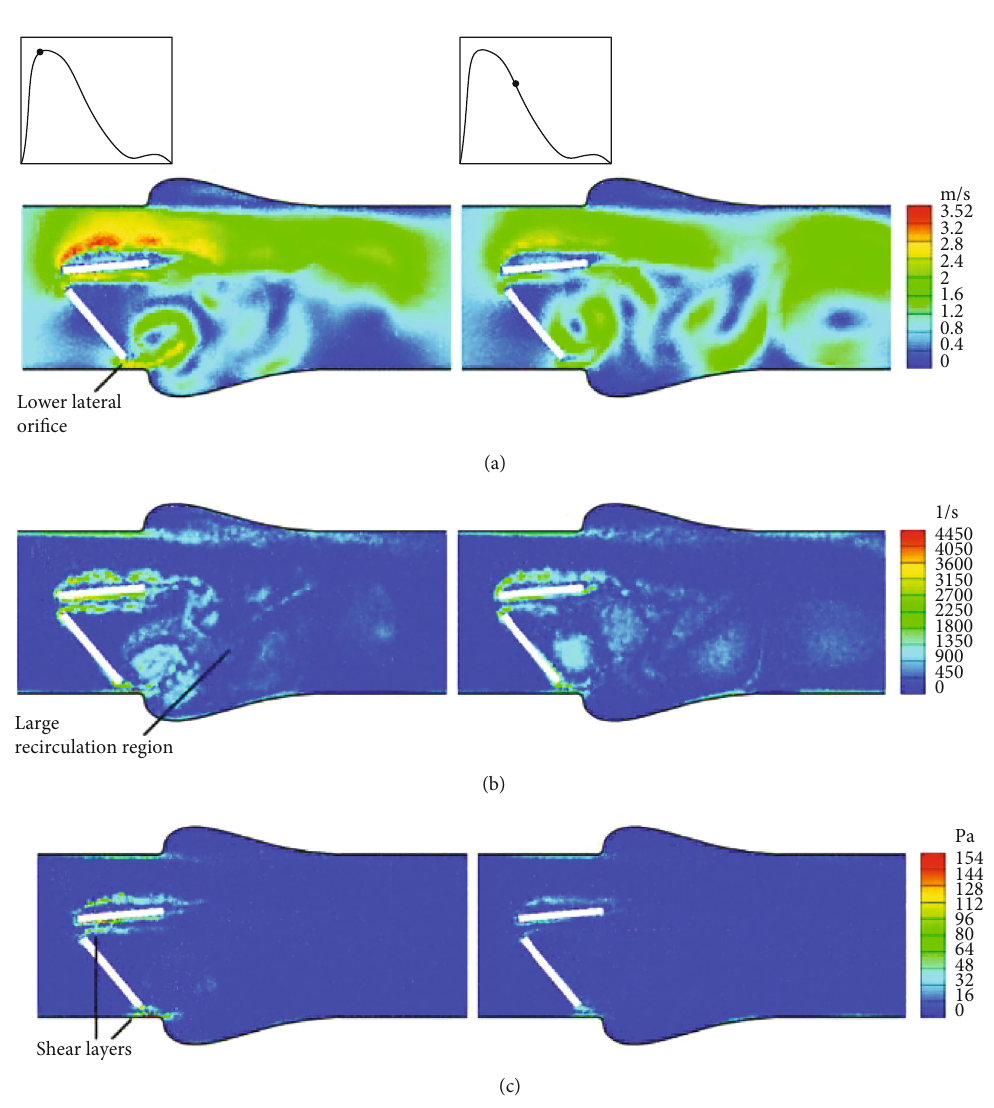
Figure 3: Flow patterns through a dysfunctional BMHV at peak systolic (0.1 s) and early deceleration phase (0.3s): (a) velocity magnitude, (b) vorticity, and (c) turbulent shear stress